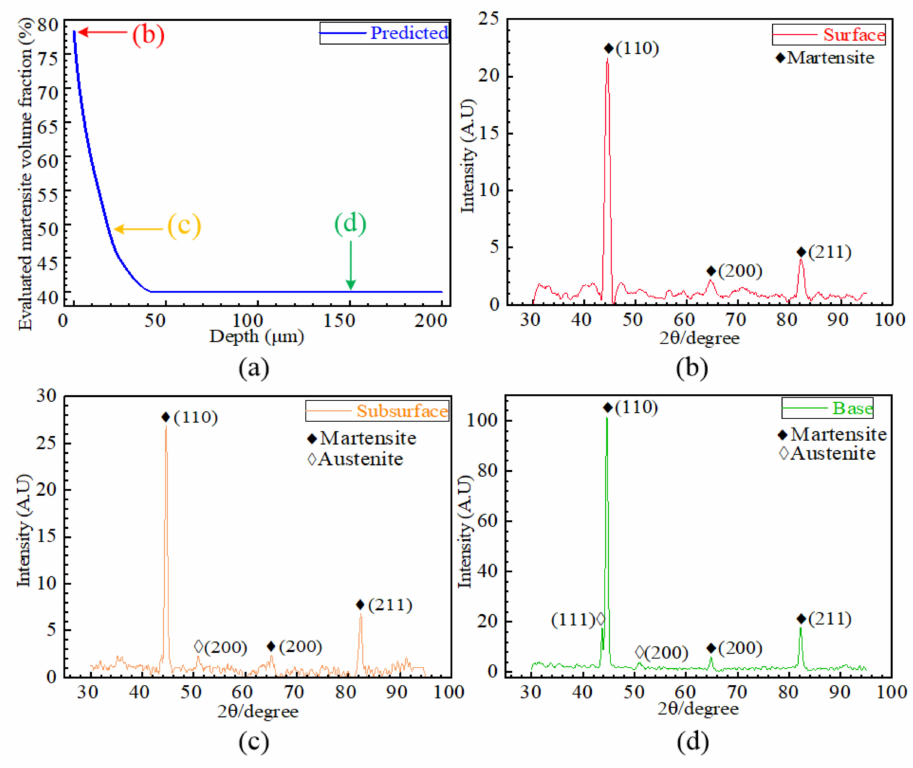
Figure 8. The evaluated martensite volume fraction and XRD analysis for phase change. ( a ) The evalu- ated martensite fraction, ( b ) surface diffractogram, ( c ) subsurface diffractogram, ( d ) base